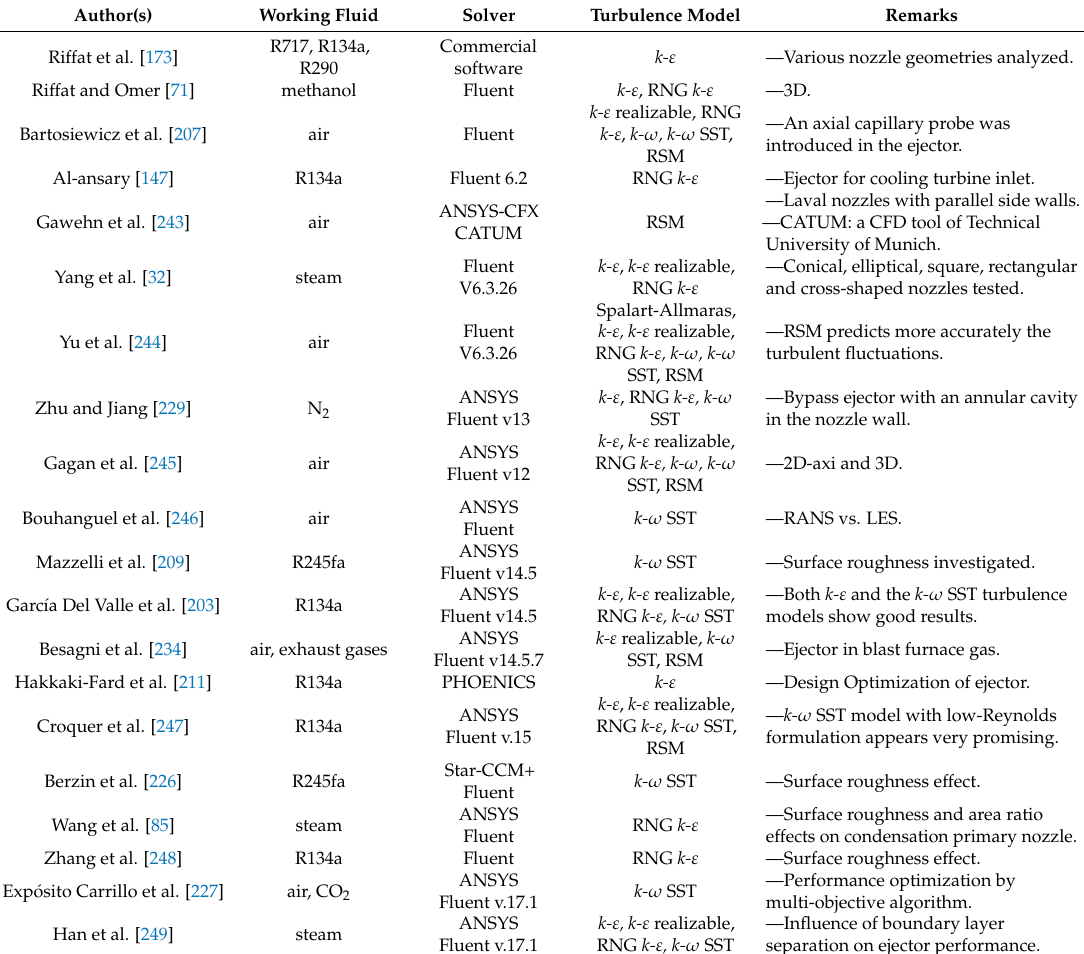
Table 3. Representative sample of computational fluid dynamics (CFD) models in the